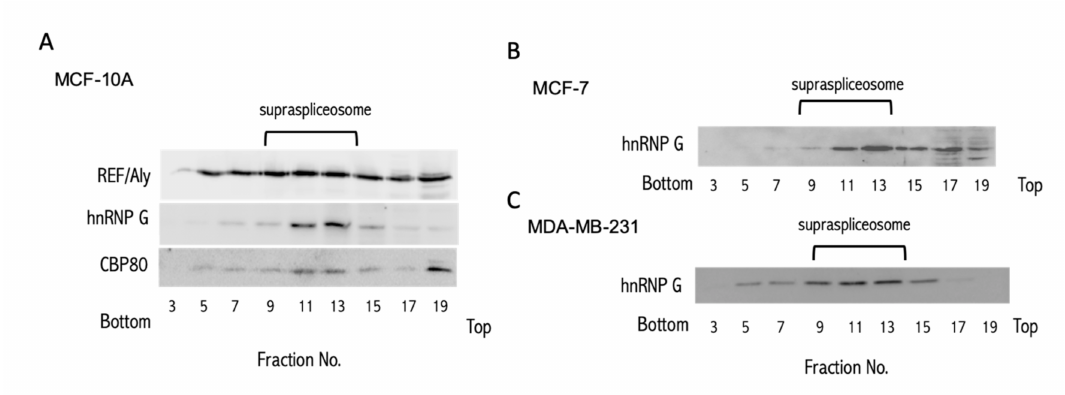
Figure 1. Splicing factors mark the supraspliceosome fraction (SF) in breast cancer cells. WB analysis of the distribution of splicing factors across the glycerol gradients. Nuclear supernatants enriched for SF were prepared from MCF-10A ( A ), MCF-7 ( B ), and MDA-MB-231 cells ( C ), and were fractionated in 10–45% glycerol gradients. Tobacco mosaic virus (TMV) was used as a size marker for the sedimentation. Aliquots from odd gradient fractions were analyzed by WB using anti-hnPNP G, anti-REF / Aly and anti CBP80 antibodies. Supraspliceosomes peak in fractions 9–13 (200S). We used the distribution of hnRNP G (42 kDa) to follow the enrichment of the supraspliceosome fractions across the